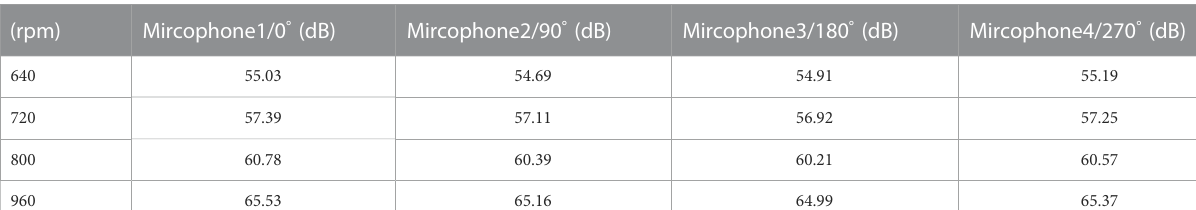
TABLE 1 A-weighted SPL of four measuring points at different rotational speeds.